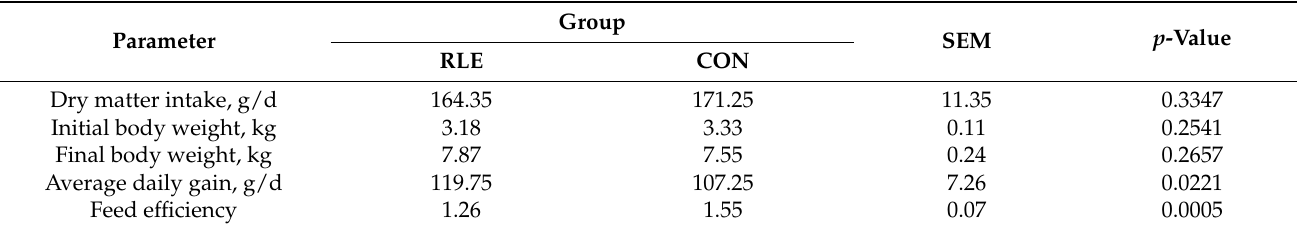
SEM, Standard error of the means; RLE, red orange and lemon extract group; CON, control group; SEM, standard error of the